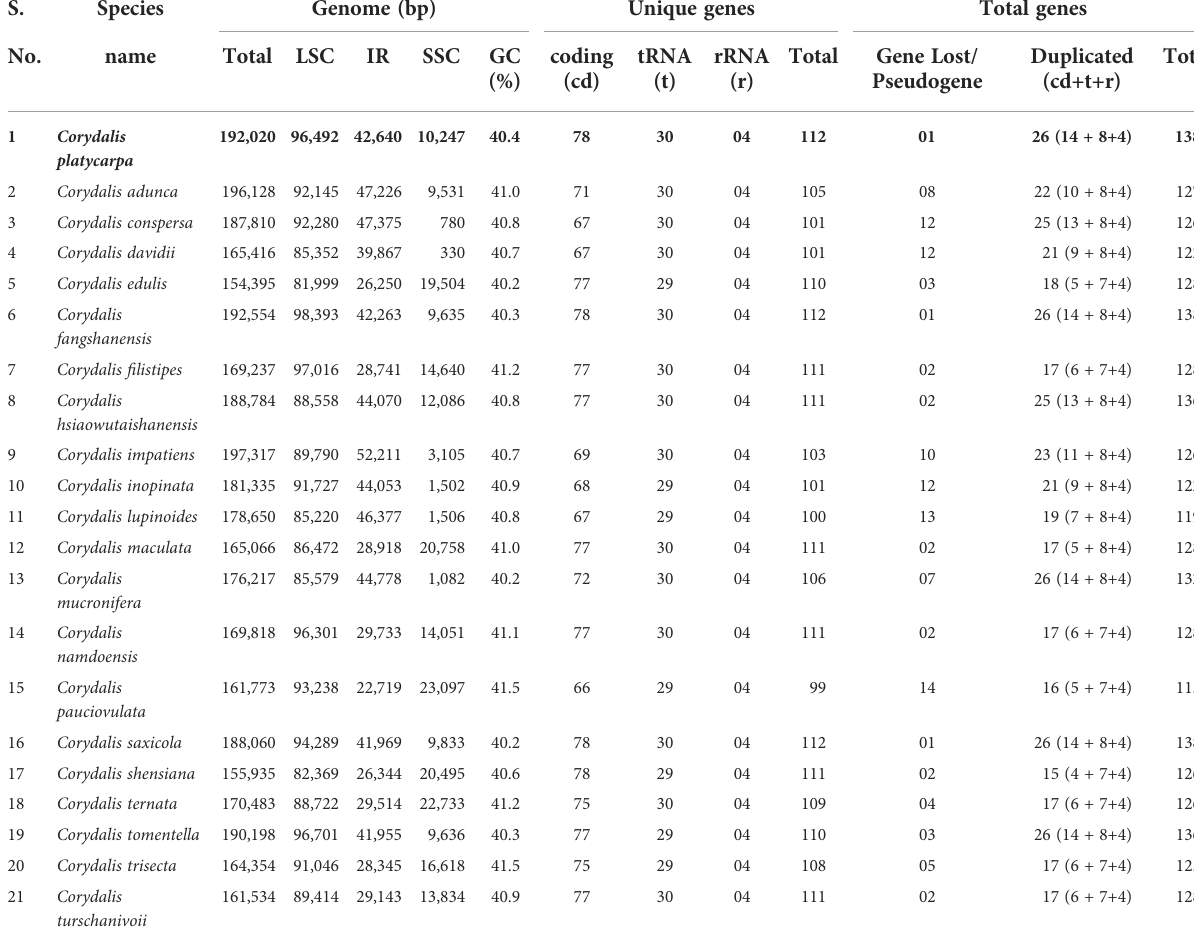
TABLE 1 The basic genomic characteristics of 21 Corydalis plastomes.